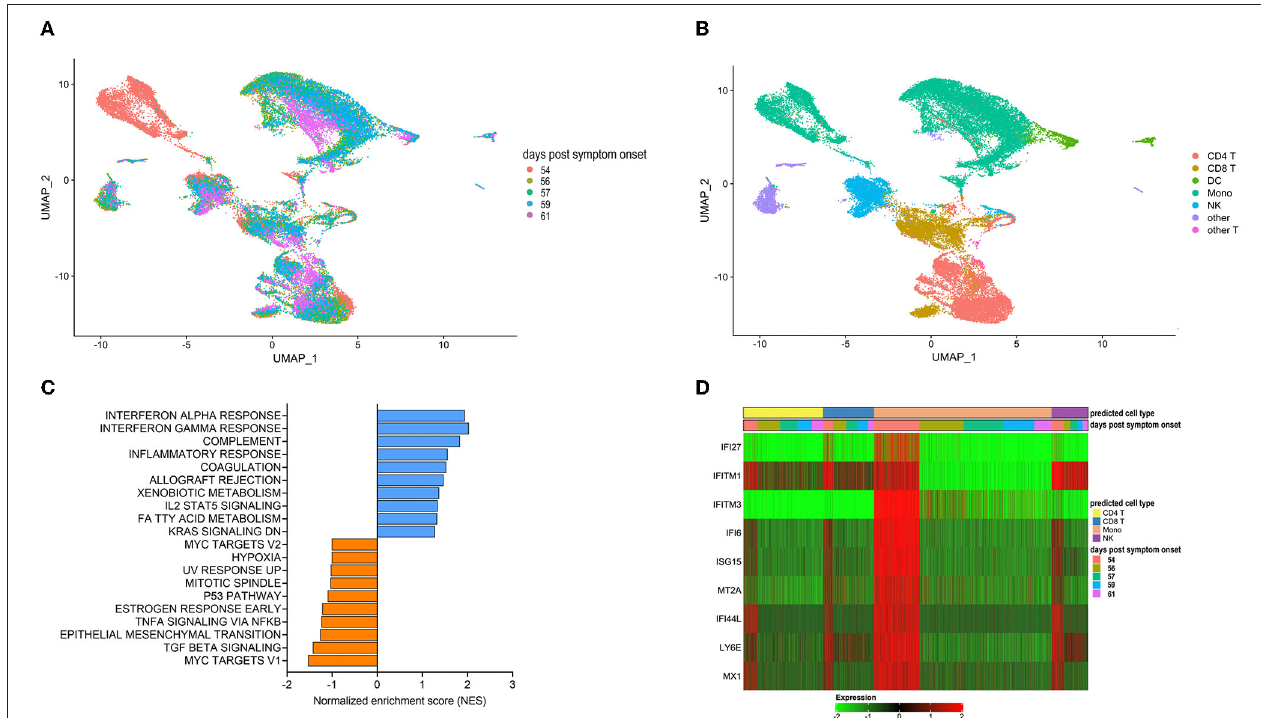
FIGURE 3 | Single cell transcriptomics of recipient’s peripheral blood mononuclear cells before and after convalescent plasma transfusion. (A) Uniform Manifold Approximation and Projection (UMAP) distribution of single cells grouped by time-post-transfusion sample. Day 0 is the sample obtained just before the first transfusion with the relative’s convalescent plasma. (B) Cell types were determined using Seurat’s MapQuery function along with their PBMC reference dataset. It is worth noting that none of the cell types identified in (B) could be assigned to B cells, both prior to the transfusion and for the duration of the post-transfusion analysis, in agreement with flow cytometry data recorded in the patient’s hospital chart, as mentioned in the legend to Figure 1 . (C) Histogram of Hallmark gene set enrichment analysis (GSEA) using differentially expressed genes of the unique monocyte cluster identified at day 0 compared to monocytes across other data clusters. (D) Heatmap showing the expression levels of type I Interferon-regulated genes in predicted T cells, monocytes, and NK cells. The color code of the “days post-transfusion” bar corresponds to the color code in (A)